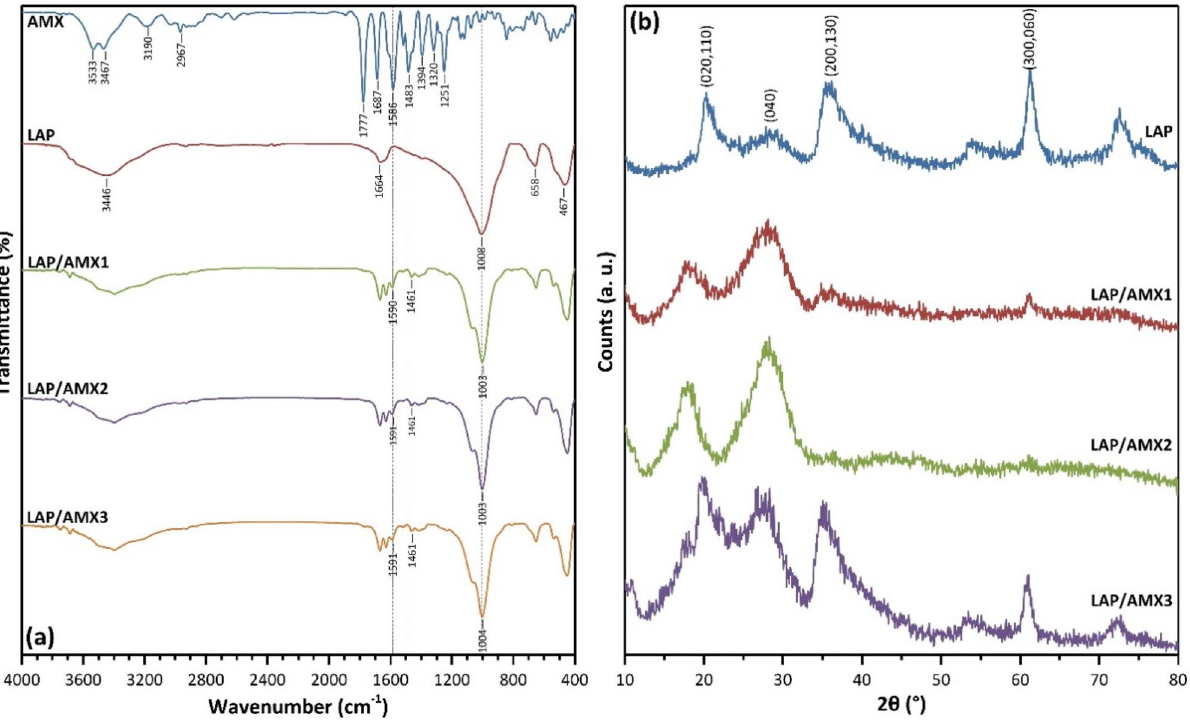
Figure 2. FTIR ( a ) and XRD ( b ) spectra of AMX, LAP, and AMX-loaded LAPs. Diffraction angle (2θ,